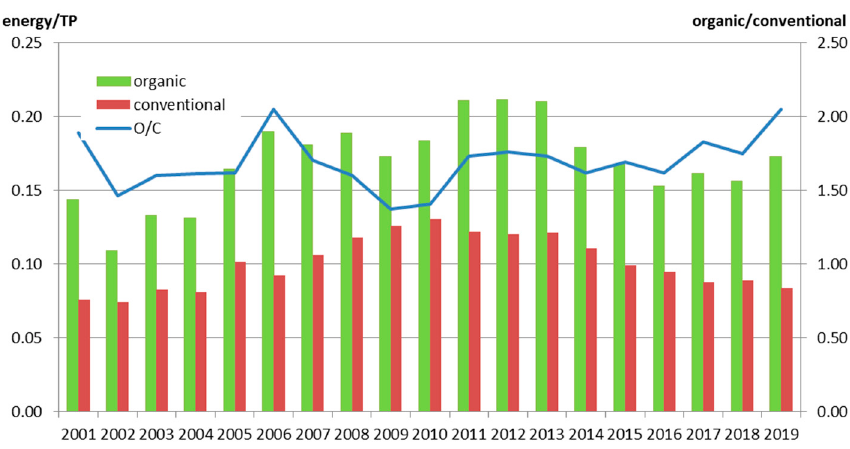
Figure 8. Energy consumption per one unit of total product (TP) in ANC. (Source: [38], authors’ elaboration). Note: Both energy consumption and total production are expressed in EUR.